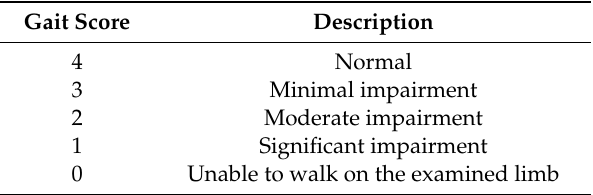
Table 1. Gait scores for mice (adapted from ref.